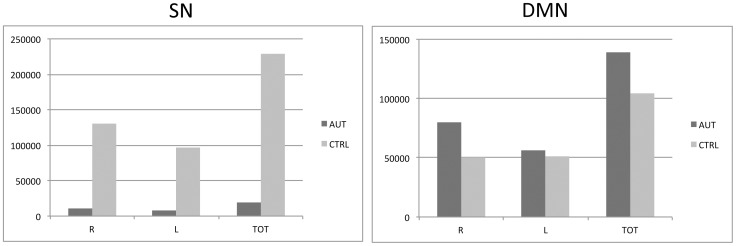
Group differences in network volume.Plots of voxel counts by group indicate substantially restricted network extent in the SN of autistic subjects, whereas the DMN is more spatially extensive in the autistic group. Y-axis scale is voxel number from associated statistical maps. AUT, autism group; CTRL, control group; DMN, default mode network; L, left; R, right; SN, salience network.